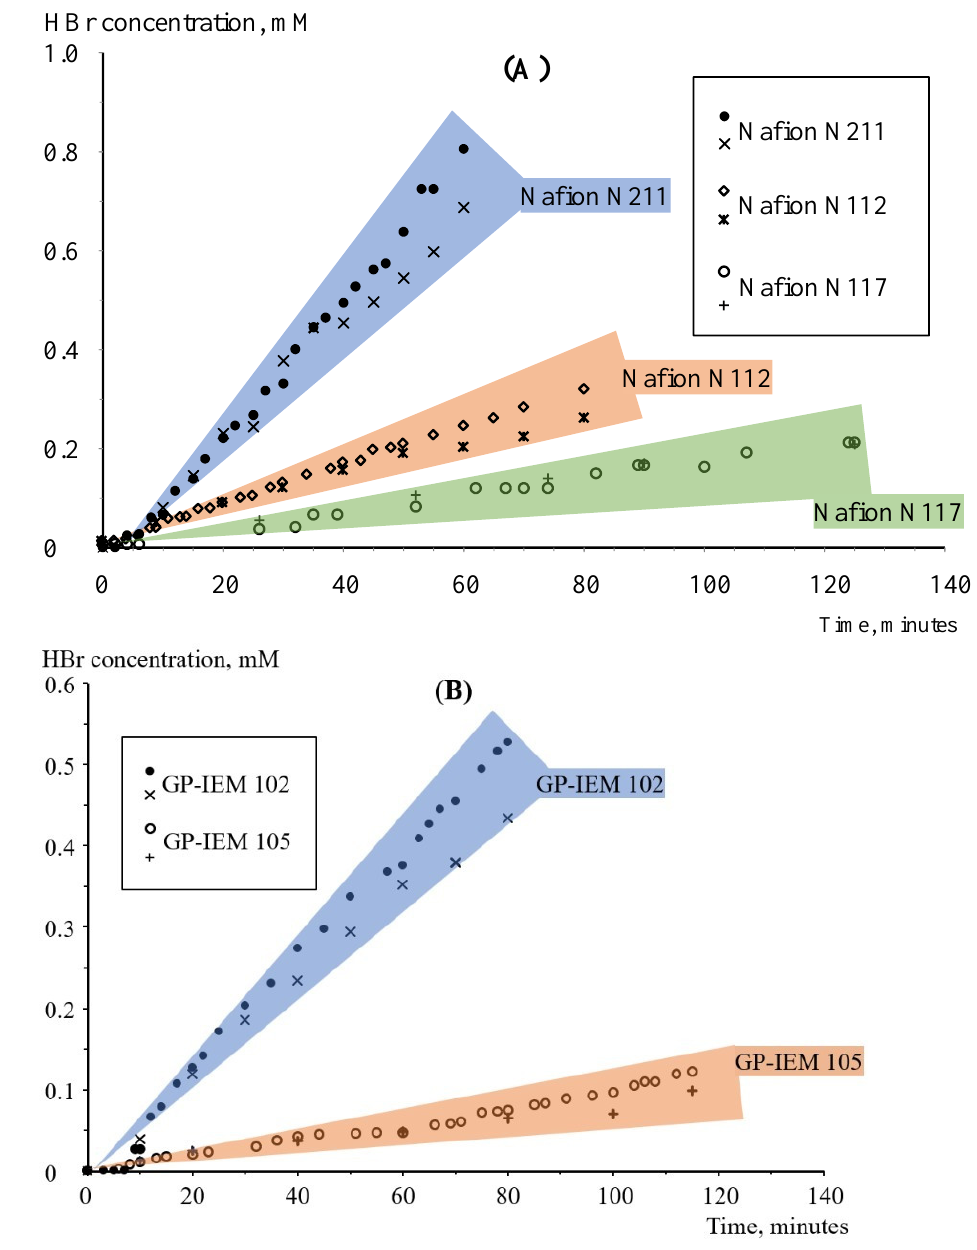
Figure 4. HBr concentration evolution over time in the three-electrode cell while studying the crossover of bromine-containing species in a flow cell at 60 ◦ C with Nafion membranes ( A ) and GP-IEM membranes ( B ). The results obtained by pH measurements are shown by circles and the results of differential pulse voltammetry are shown by crosses.